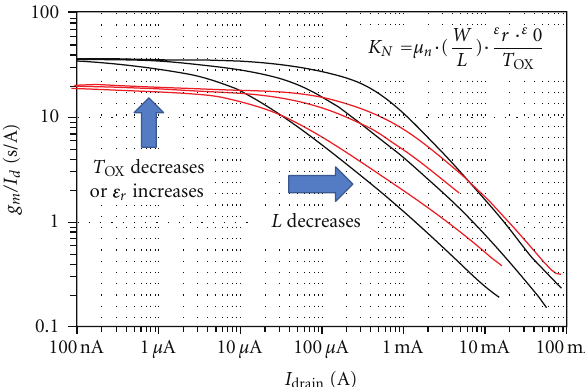
Figure 11: Use of the transconductance figure of merit to evaluate process changes. E ff ect of increasing oxide dielectric constant, increasing length or decreasing oxide thickness. The red line is a thick-oxide transistor; the black lines are from a thin oxide transistor. Both sets of curves are from transistors of a width of 100 μ m and lengths L = 5 μ m, 1 μ m, and 0.5 μ m from left to